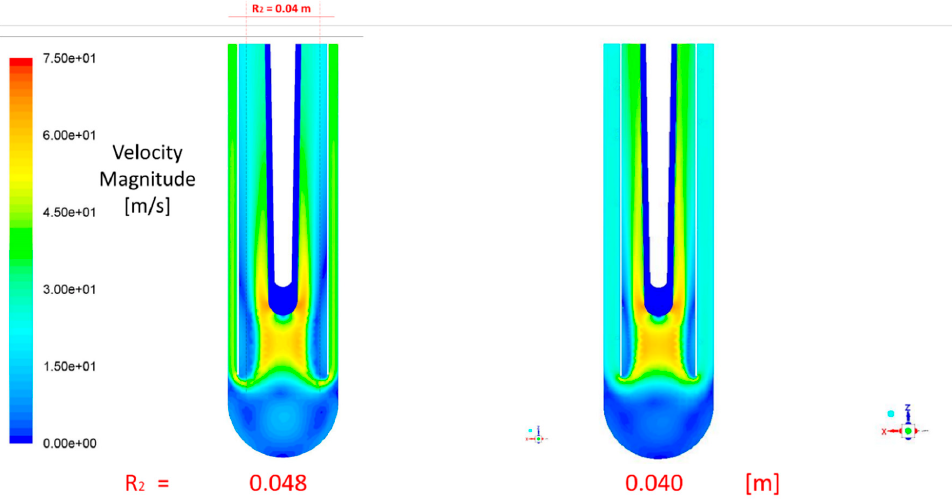
Figure 9. Velocity fields comparison for R 2 equal to 0.04 and 0.048 m.